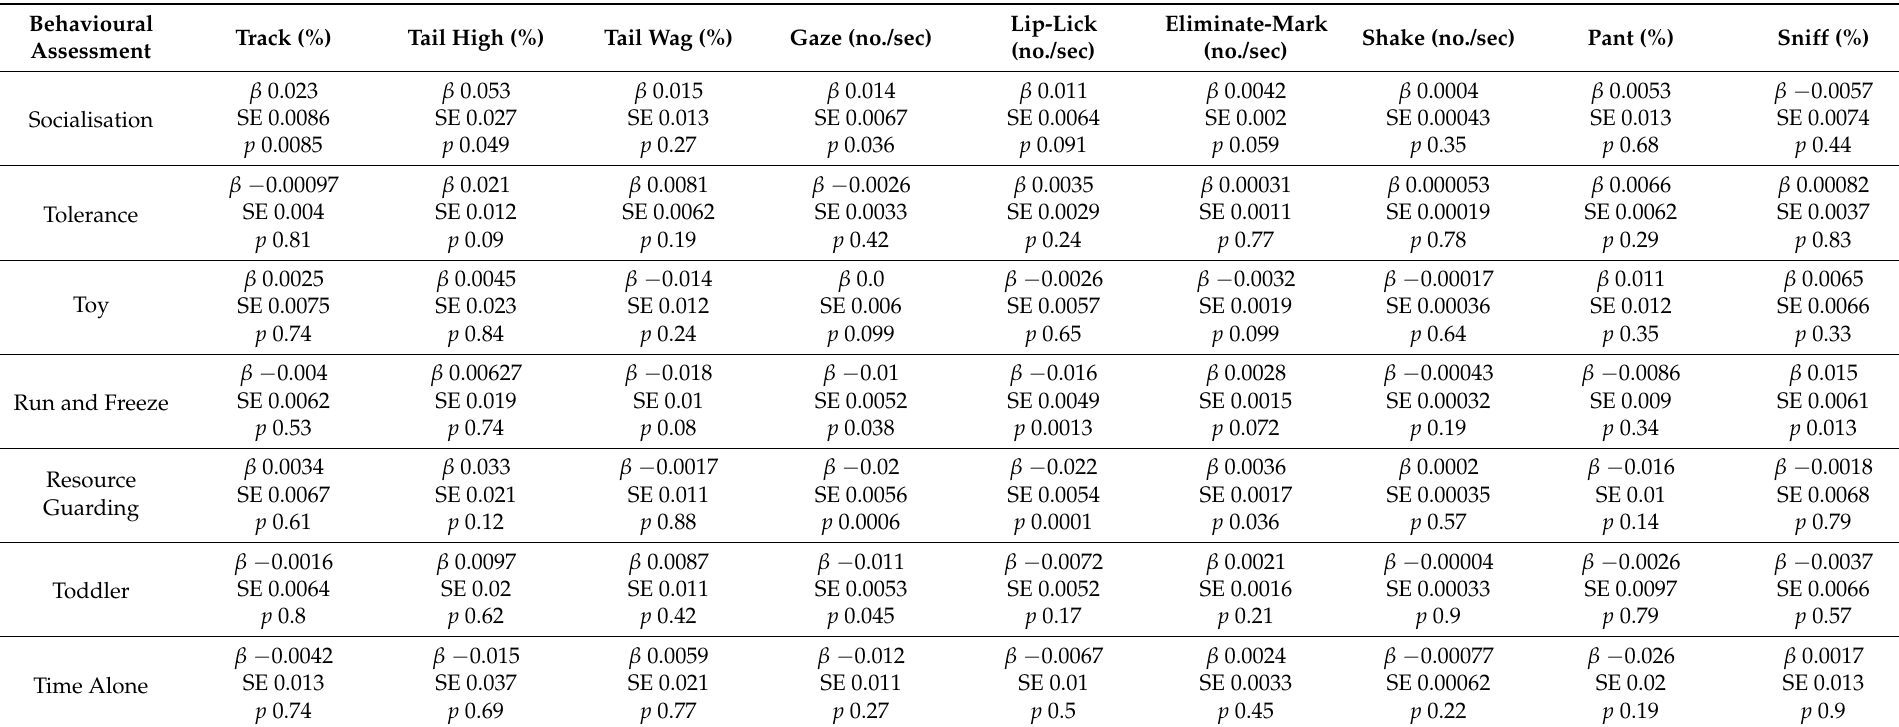
Table 6. Generalised linear mixed model of the effect of canine behavioural assessment on canine